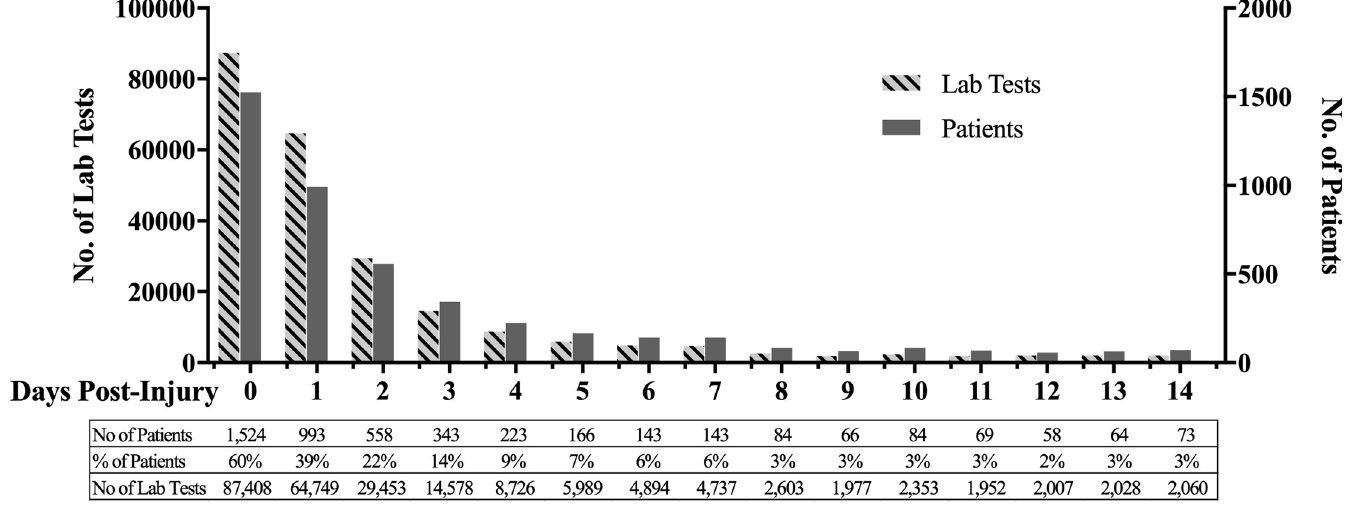
Fig 1. Frequency of laboratory analysis days following